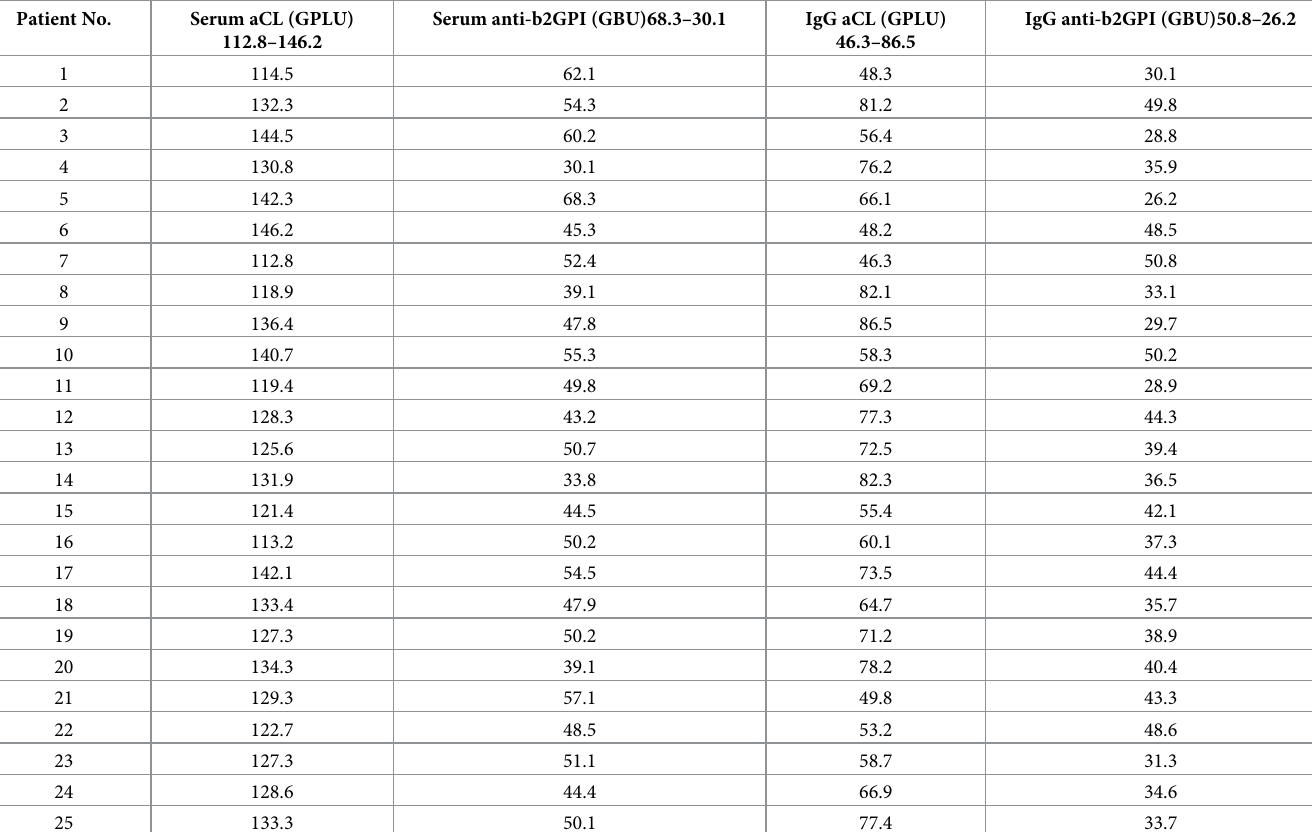
Table 1. aPLs profile of 25